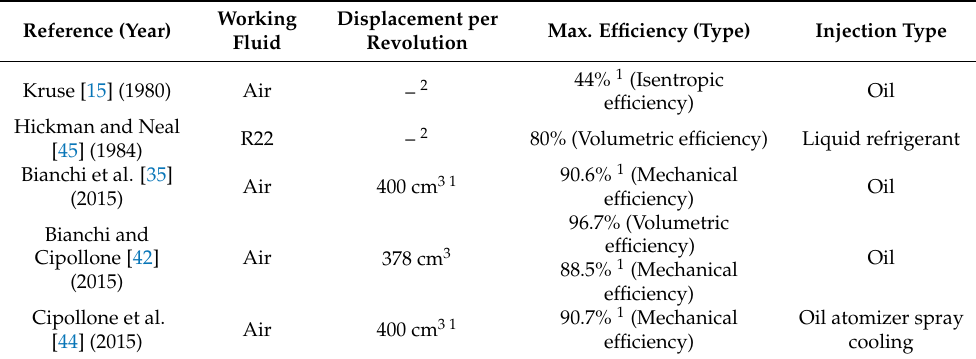
Table 3. Sliding vane compressor performance with injection